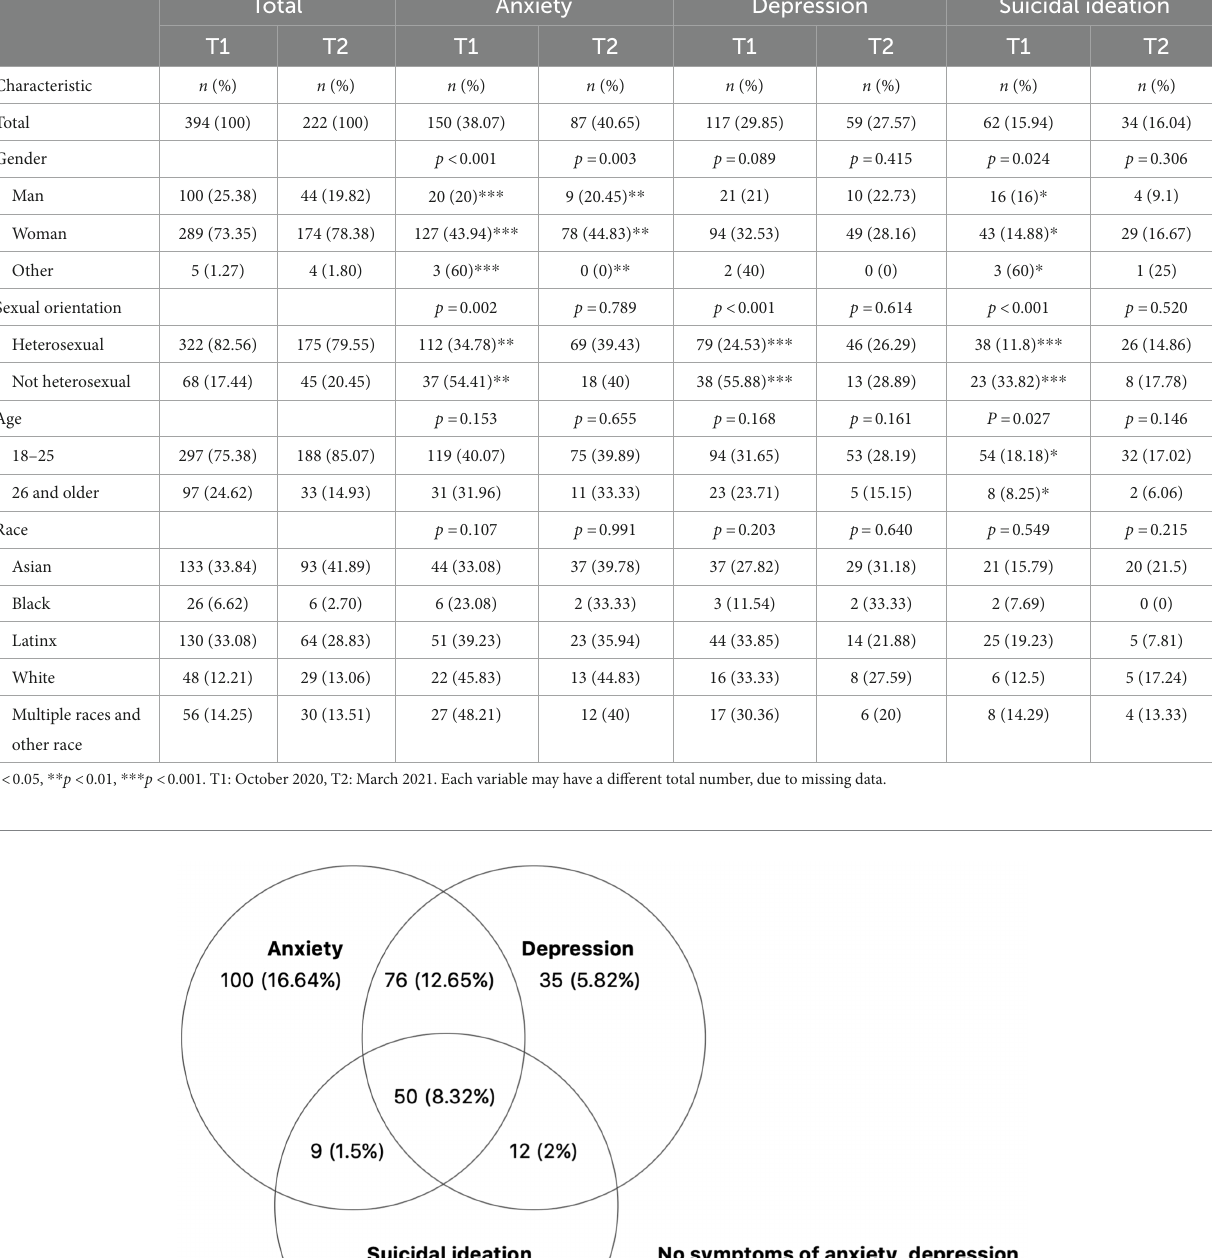
prevalence of coping by sleeping than students who did not report feeling lonely (PR 2.25, 95% CI 1.19, 4.23, p = 0.012). The March 2021 survey asked participants to report on their overall mental health: almost half of the participants’ reported that their mental health had become worse since the pandemic (46.40%),